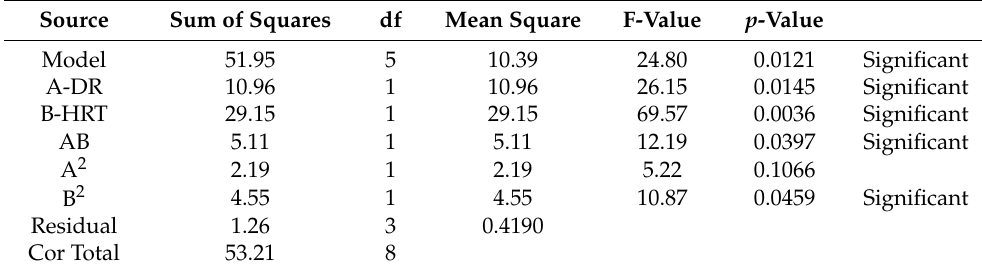
Table 6. ANOVA for quadratic model response 2: